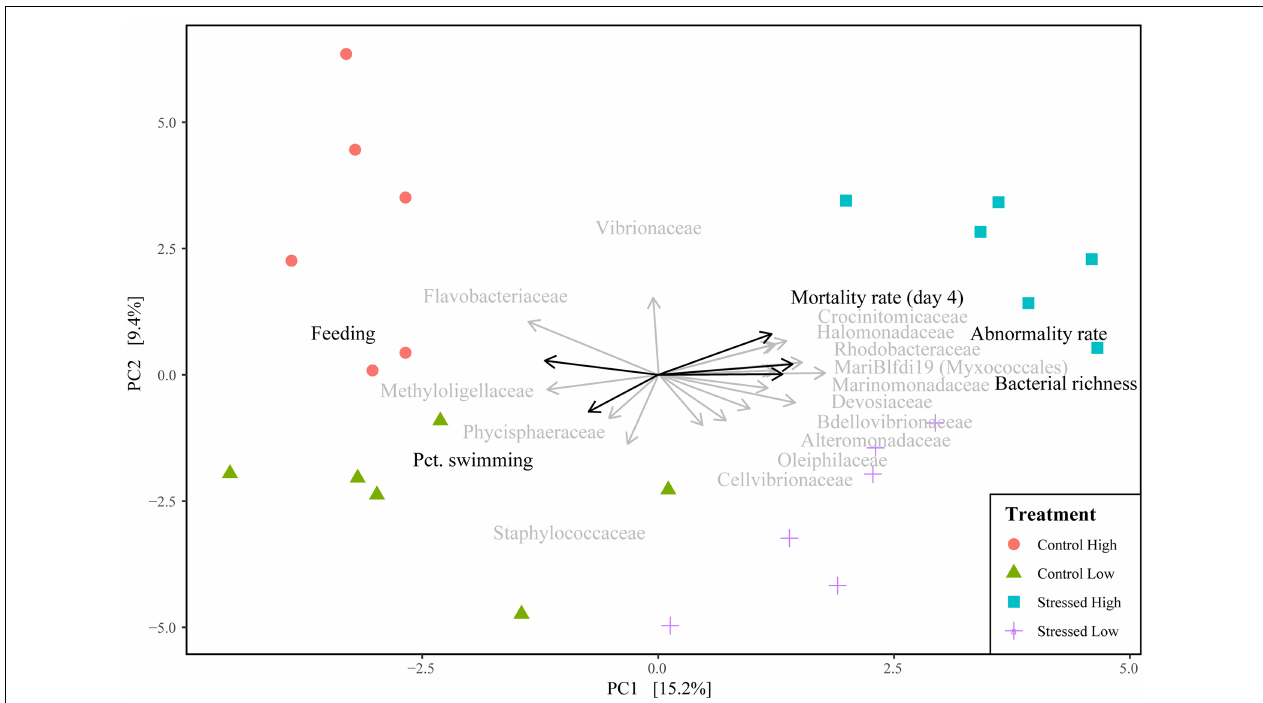
FIGURE 8 | Principal components analysis (PCA) of community composition of Crassostrea gigas larvae after 96 h of exposure to stressed algae per treatment condition (Control Low, Control High, Stress Low, and Stress High). The 15 most important families are displayed as vectors (gray arrows) using the mean score value of their associated ASVs.